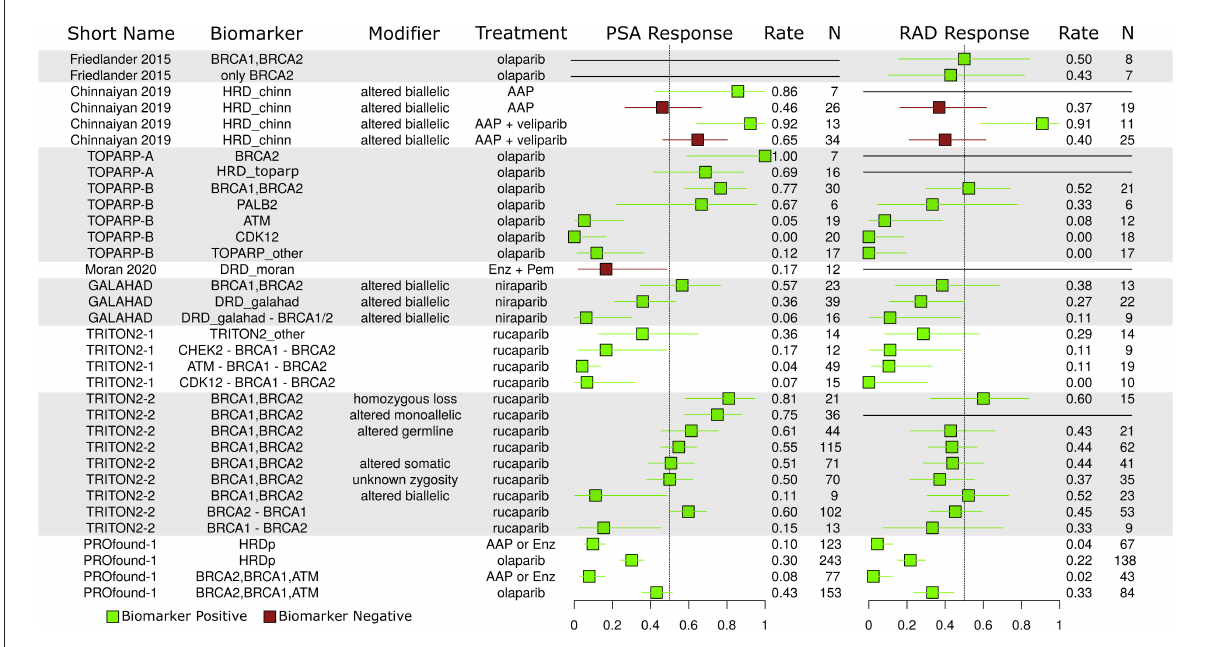
FIGURE5 Reported PSA and radiographic (RAD) response rates. Green, population with biomarkers; Red, population w/out biomarkers.